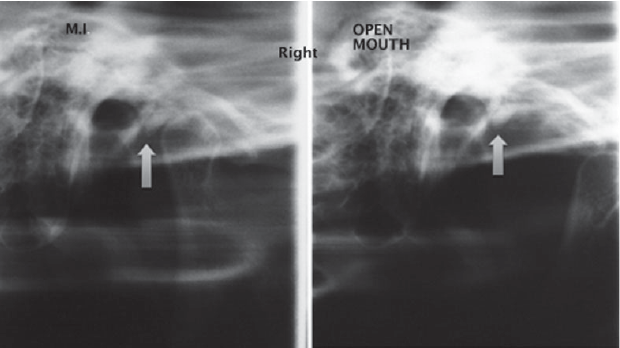
Fig. 3. Case 2. Sagittal view (CBVT) of left and right condylar head. Arrows point he loose bodies.